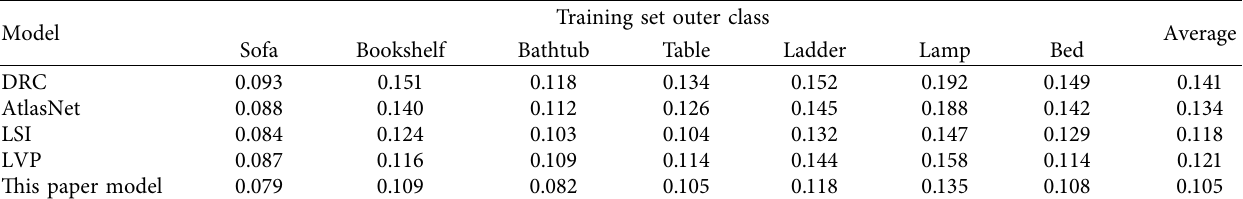
Table 5: Test results of chamfering distance of each model outside the training set.